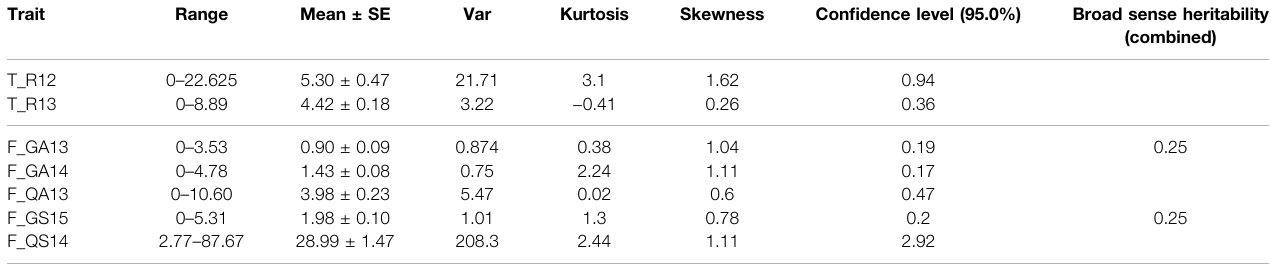
TABLE 2 | ( Continued ) Descriptive statistics of various traits of investigated insects in winter wheat (WW) panel. For details, see materials and methods. Trait